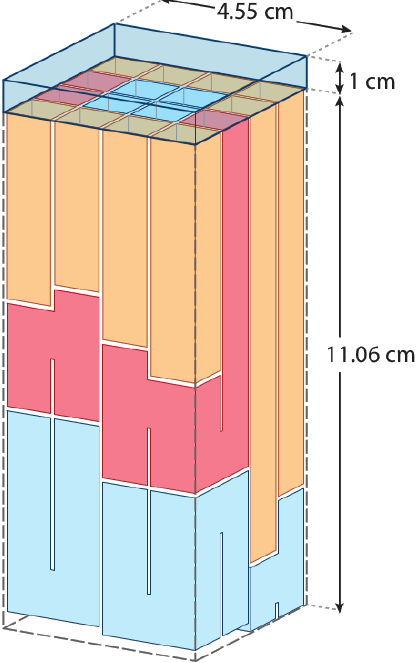
Figure 4. The original “optimal” absorbing metamaterial obtained by Yang et al. The unit cell is composed of 16 resonant channels differing in length and folded to compact the sample (image from